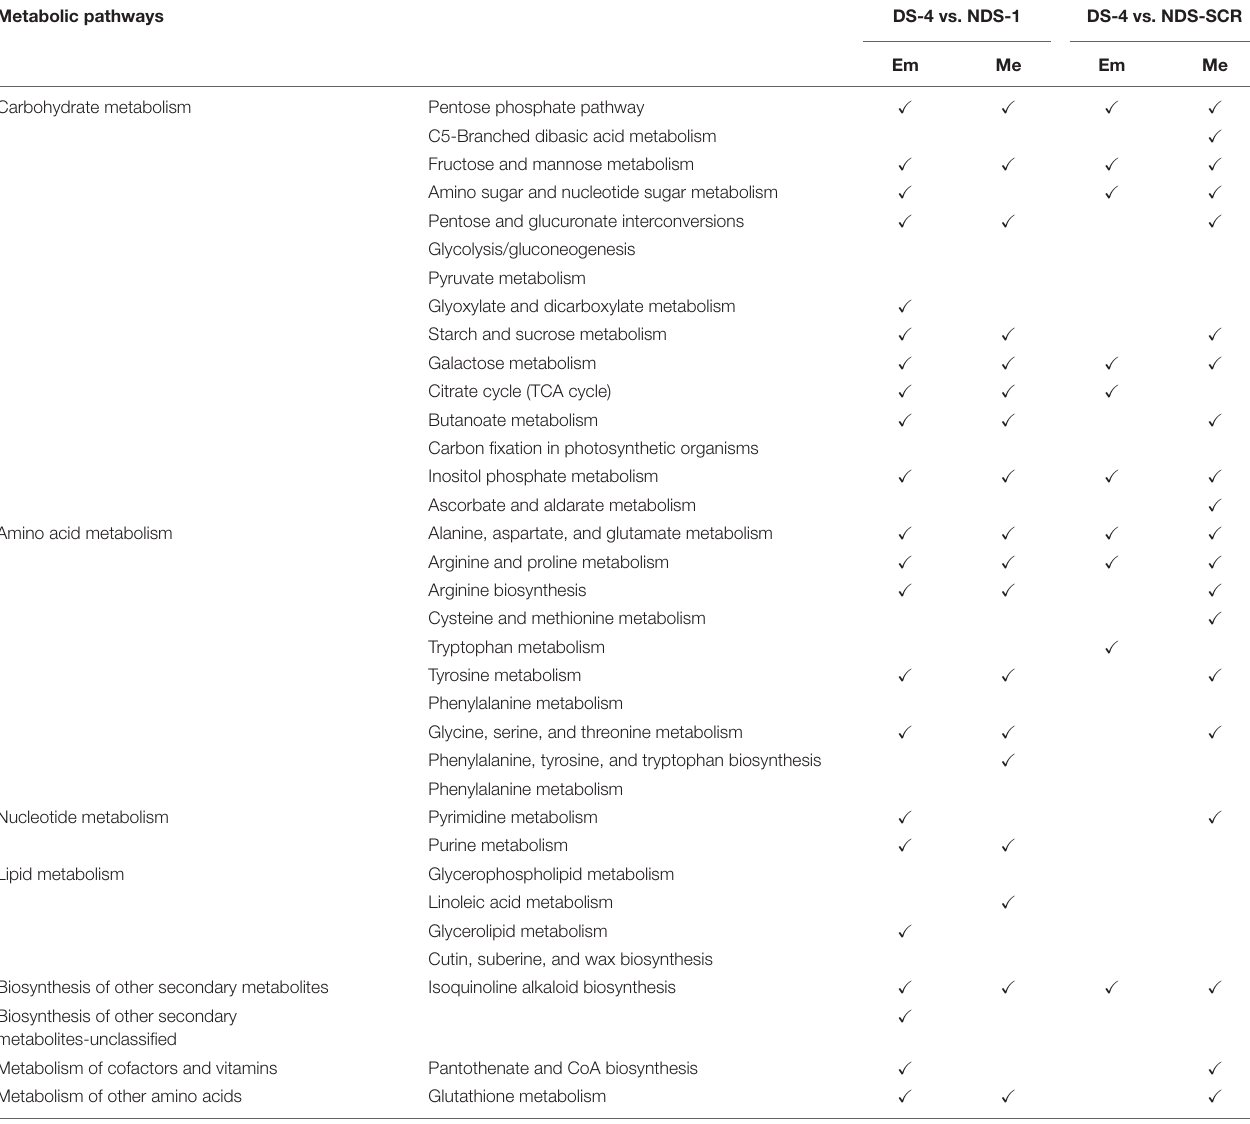
TABLE 3 | The altered metabolic pathways in the embryos and megagametophytes between 4-weeks-incuabted primary physiological dormant seeds (DS-4) and 1-weeks-incubated non-primary physiological dormant seeds (NDS-1), between DS-4 and NDS at seed coat rupture stage (NDS-SCR). Metabolic